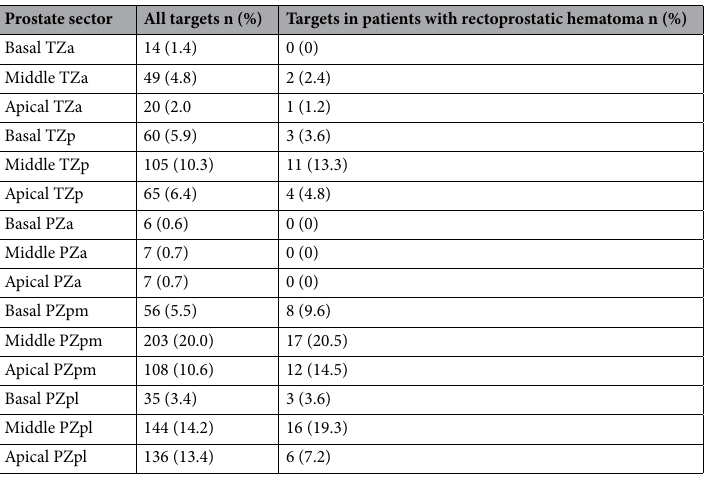
Table 2. Distribution of in-bore biopsy targets to the prostate sectors. TZ transition zone, PZ peripheral zone, a anterior, pm posteromedial, pl posterolateral.